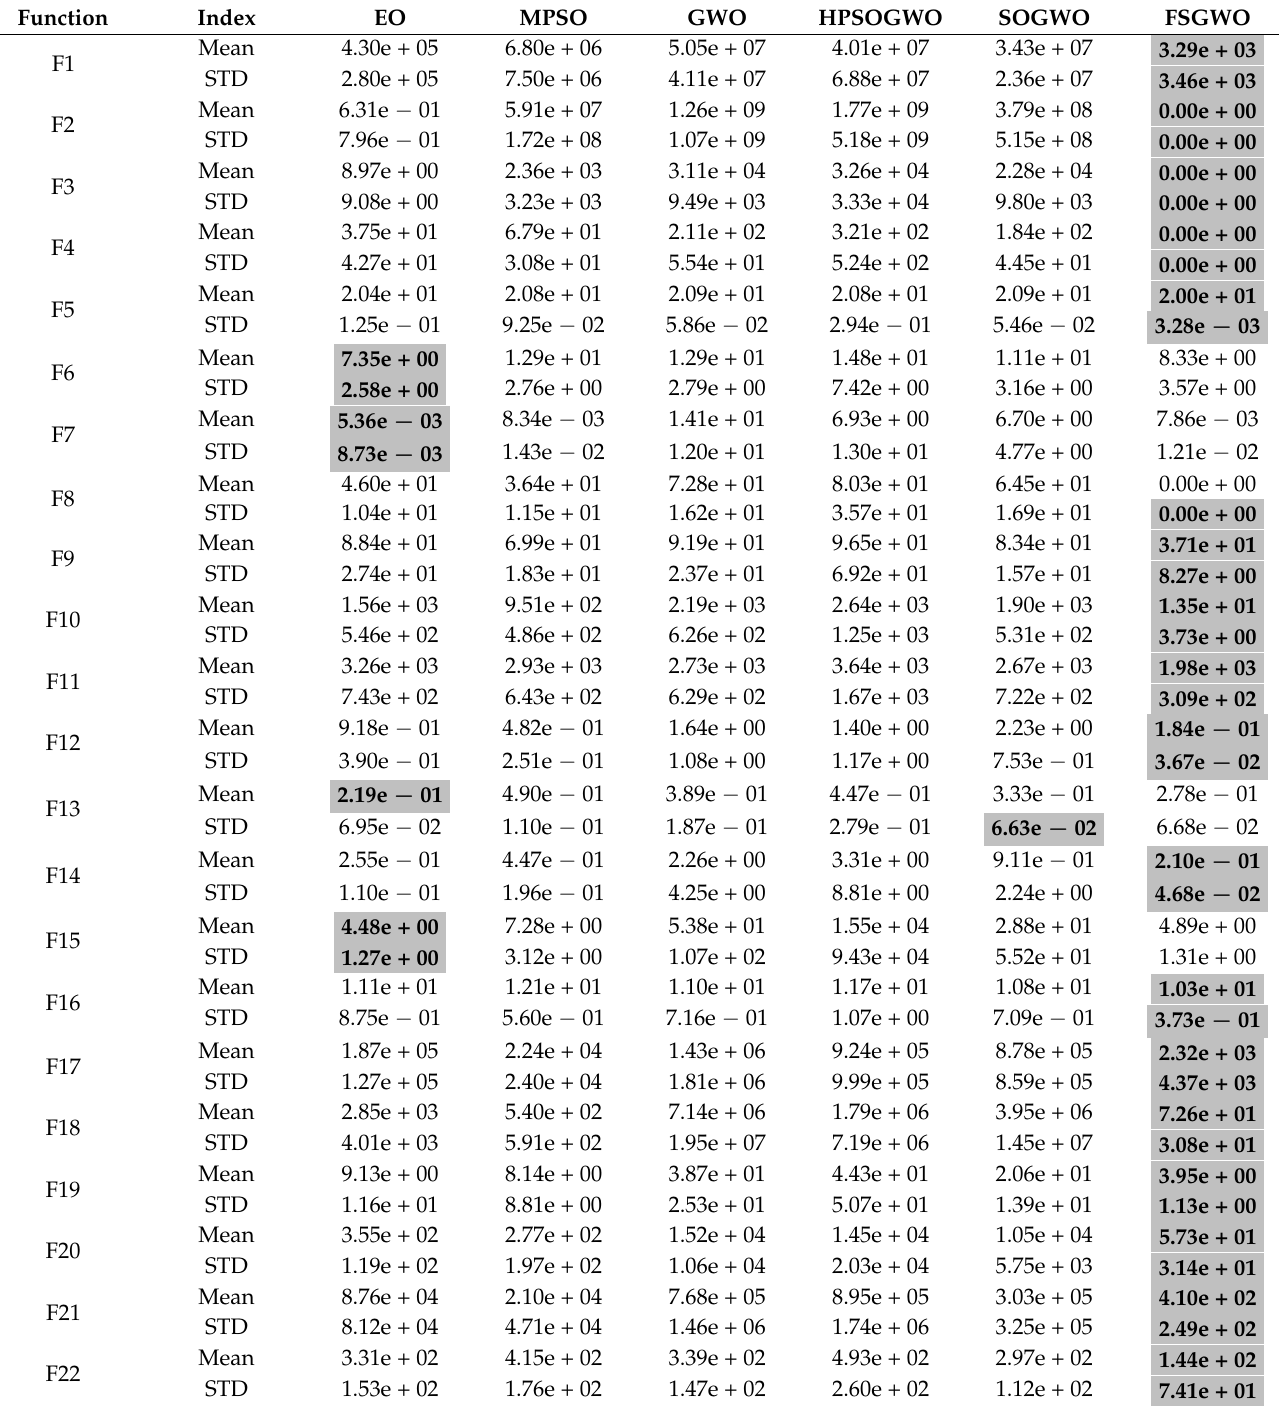
Table 2. Results of the related algorithms for 30-dimensional test